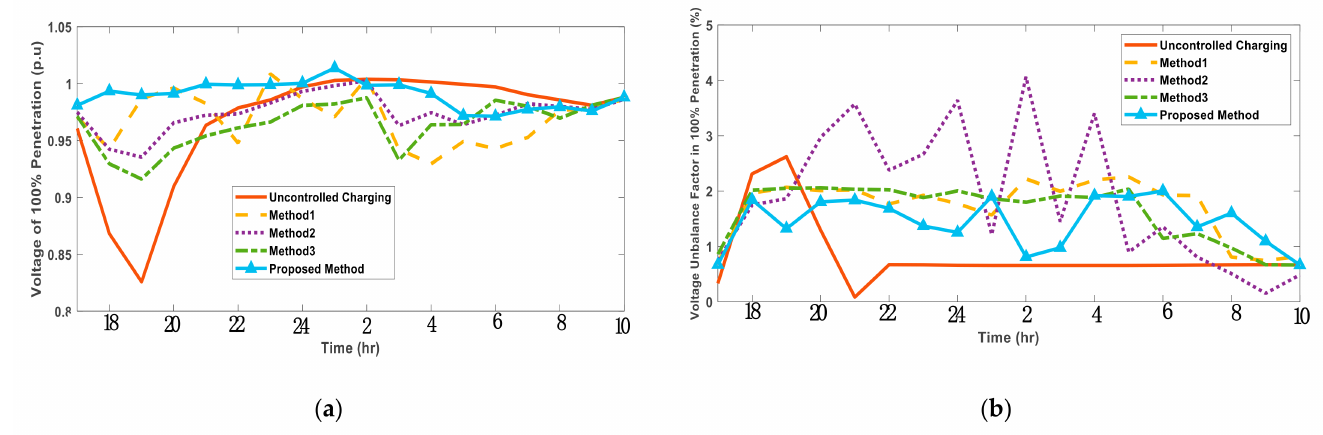
Figure 12. Bus 846 ( a ) voltage and ( b ) VUF under 100% EV penetration.